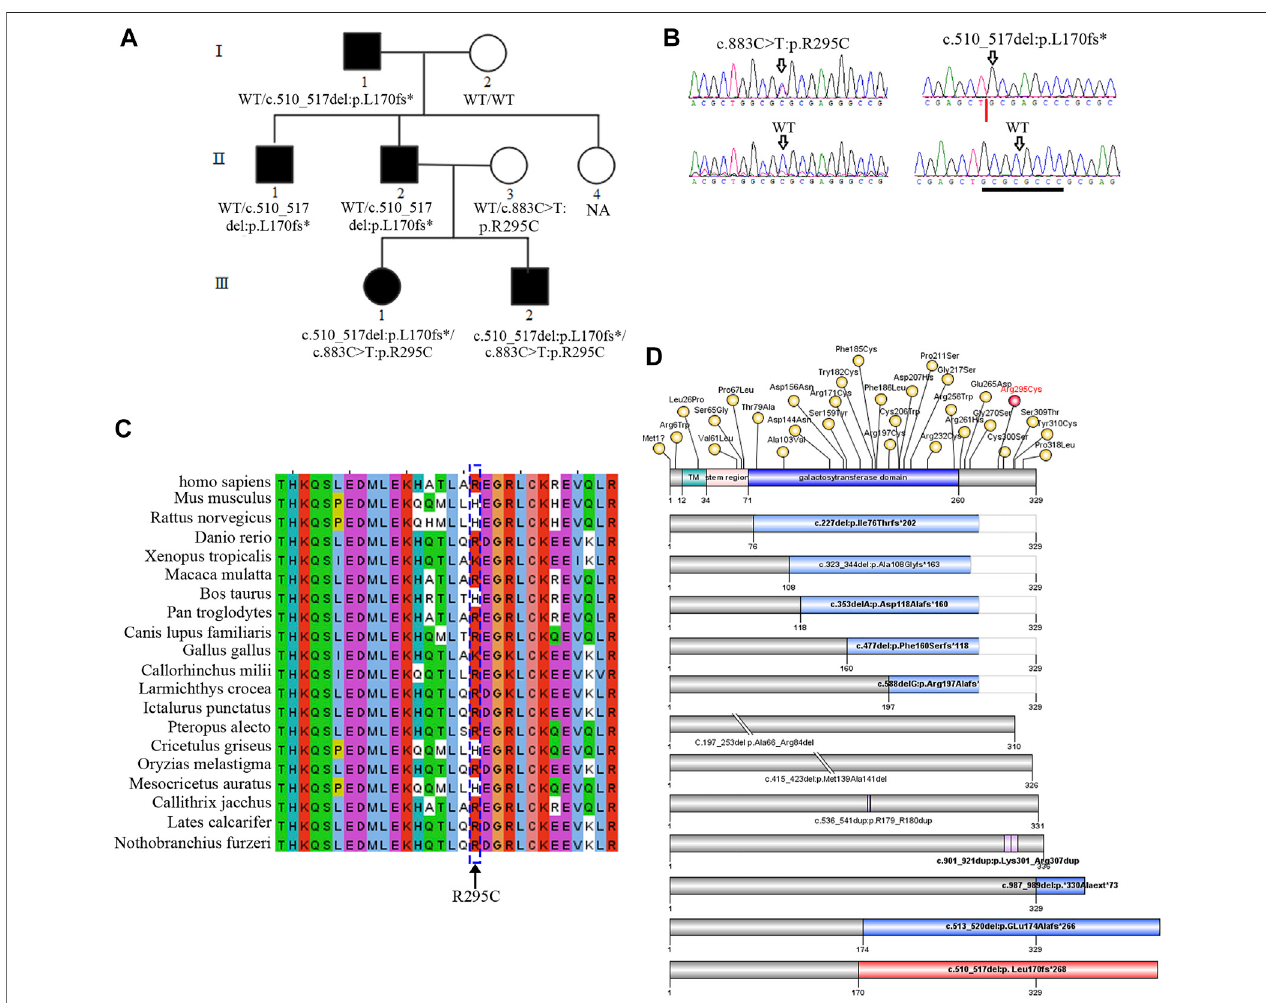
FIGURE 1 | B3GALT6 mutated in an autosomal-dominant family. (A) Pedigree with fi ve affected members. NA, genomic DNA was unavailable. (B) Two variants in the family, i.e., c.883C > T:p.R295C and c.510_517del:p. L170fs*268. Note: the trace fi gure of c.510_517del was identi fi ed by Sanger sequencing after the PCR fragment TA-clone experiment. (C) Protein sequence alignment of the residue 295 (arginine) across different species. (D) Schematic view of β 3Galt6 protein and the position of the pathogenic variants reported so far. The upper bar represents the domain structure of wild-type (WT) β 3Galt6. Missense variants identi fi ed so far weredepictedabovetheWT- β 3Galt6,andindelvariantsweredepictedbelowtheWT- β 3Galt6.TM,transmembraneregion.Note:variantsdepictedasredwerefoundin this